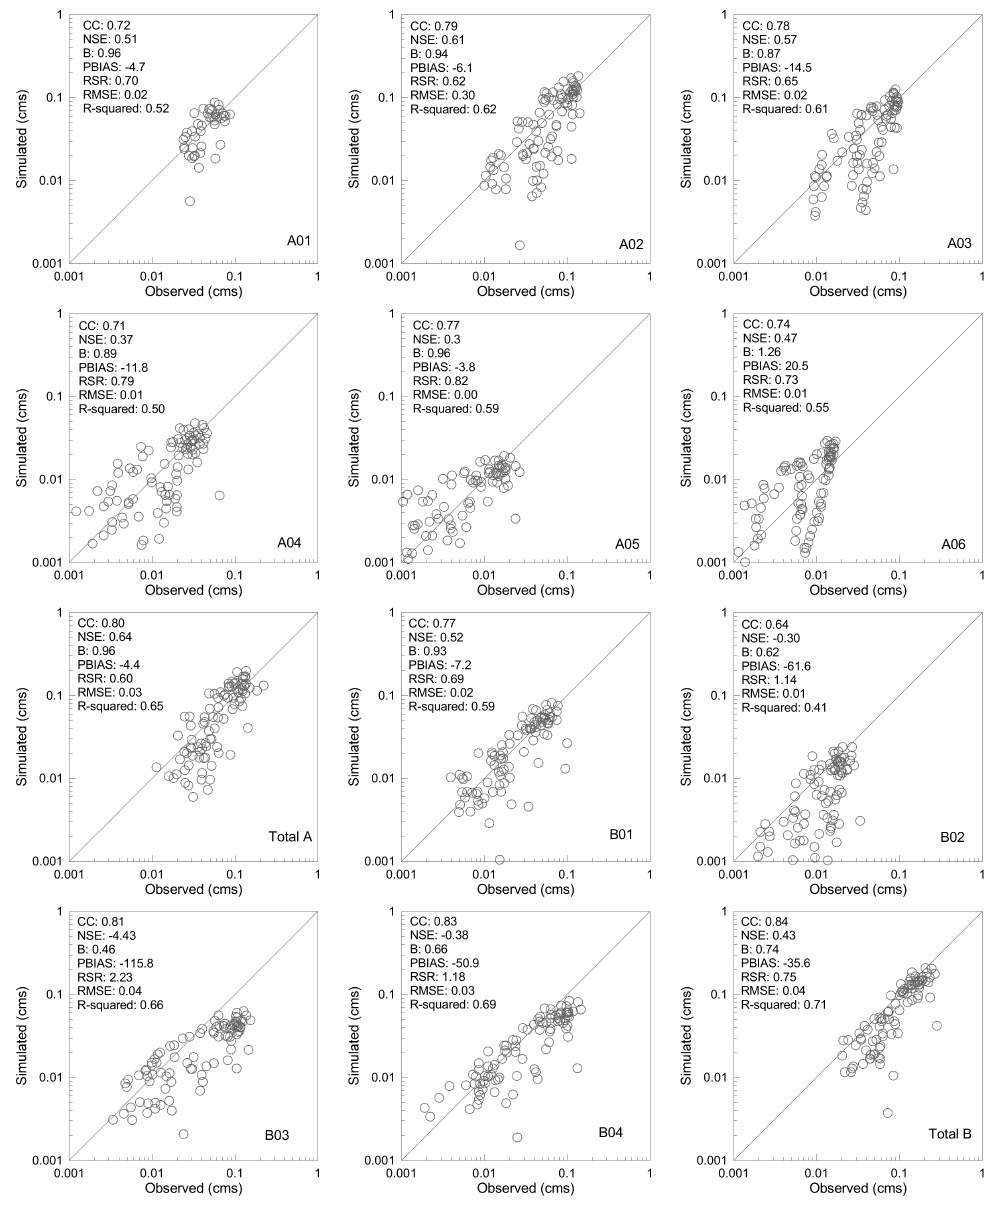
Figure 5. Calibration results for each sub-basin of the study area using observed and simulated runoff flows for the E1 and E2 storm events. In this figure, correlation coefficient (CC), Nash-Sutcliffe efficiency coefficient (NSE), Bias (B), percent bias (PBIAS), RMSE-observations standard deviation ratio (RSR), root-mean-square error (RMSE), and R-squared are used as error indices to verify the calibration